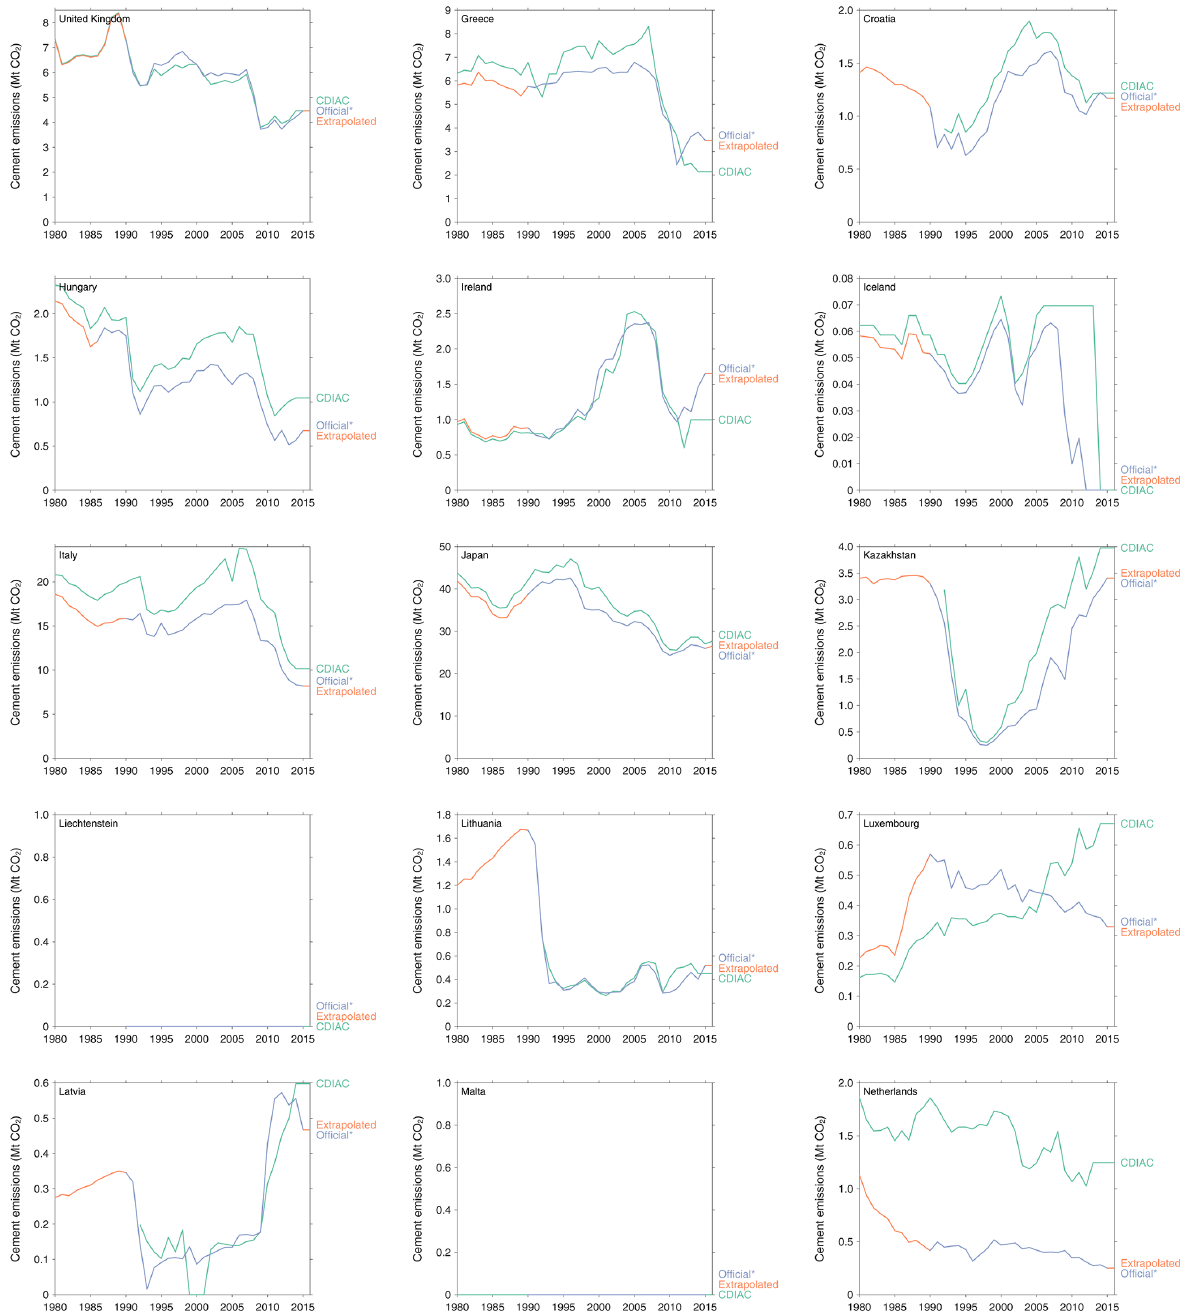
Figure D2. Revised cement emissions for Annex I parties to the UNFCCC.